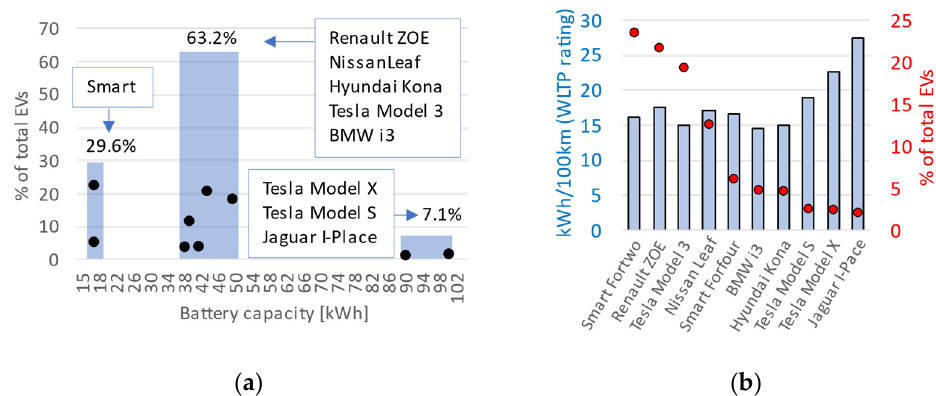
Figure 3. Data of EV batteries and consumption referred to the vehicles registered in Italy in 2019: ( a ) the percentage of the batteries’ capacity; and ( b ) the specific consumption for each EV model compared to the percentage of registered models.